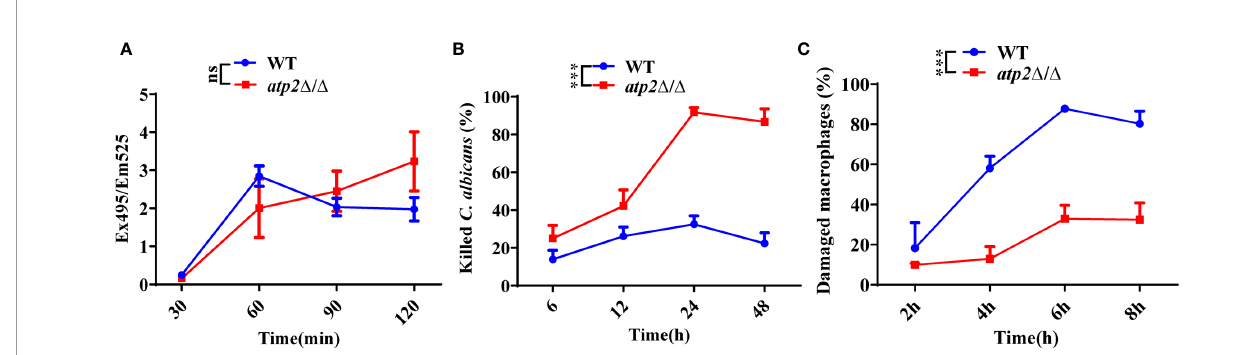
FIGURE 1 | ATP2 modulates the C. albicans -macrophage interaction in vitro . (A) The phagocytosis of FITC-labeled WT and atp2 D / D cells by macrophages was evaluated by measuring FITC fl uorescence (Ex495/Em525) in macrophages. (B) Percentage of C. albicans cells killed by macrophages over time. WT and atp2 D / D cells were cocultured with RAW264.7 cells at a ratio of 2:1 (MOI of 2), and the killing rate was determined by comparison with C albicans recovered without RAW264.7 cells at each time point. (C) Percentage of C. albicans -induced macrophage damage was assessed by measuring the release of LDH at each time point. In (A – C) , assays were performed in triplicate. Data are shown as mean ± s.d. *** P <0.001; ns, not signi fi cant; by two-way